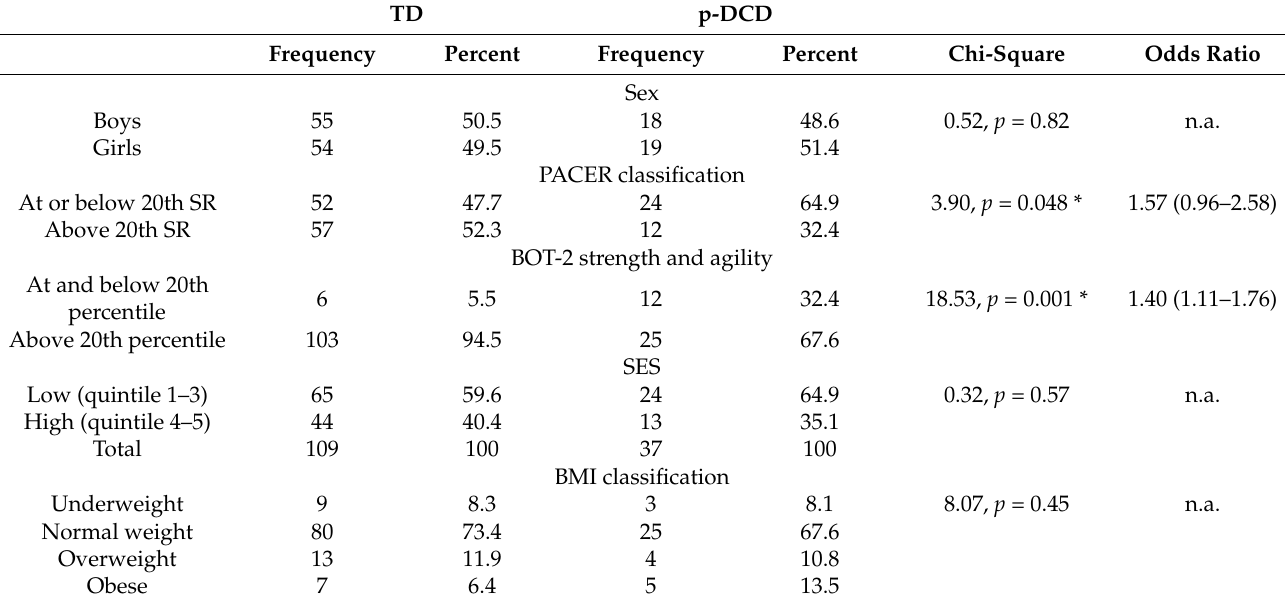
Table 1. Frequency of participants in different BMI, PACER, and BOT-2 classifications, and statistics.